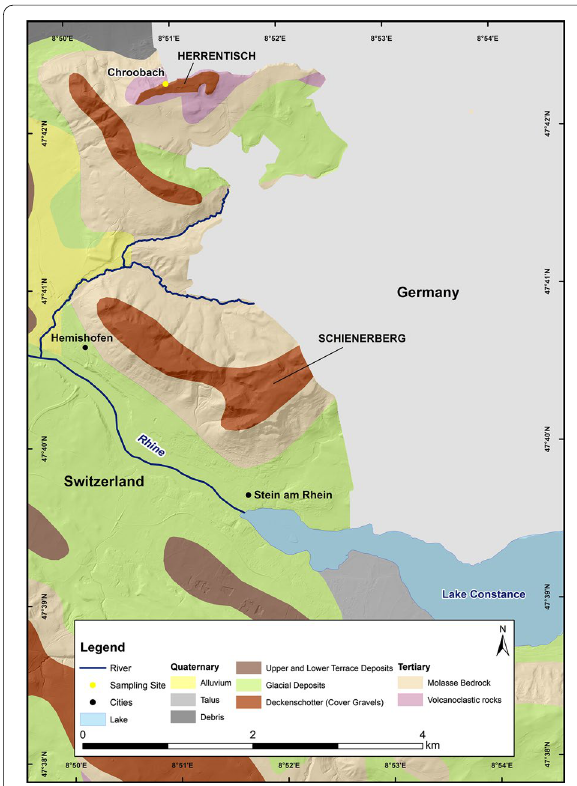
Fig. 3 Simplified geological map of the Lake Constance region. ©Federal Office of Topography, swisstopo, CH-3084